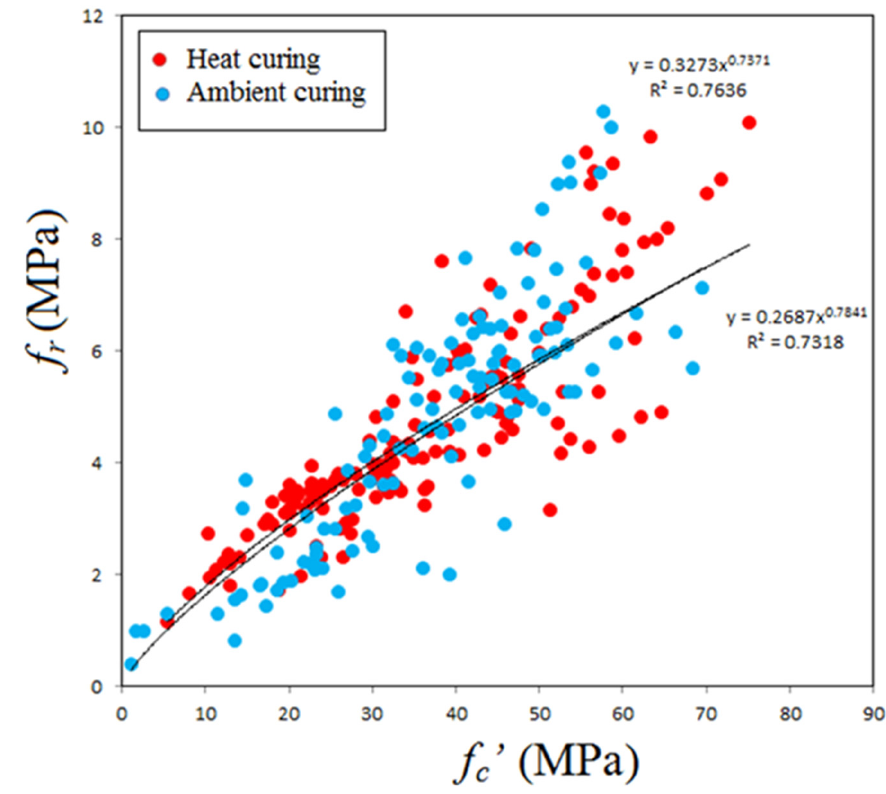
Figure 8. Variation of flexural strength with compressive strength.